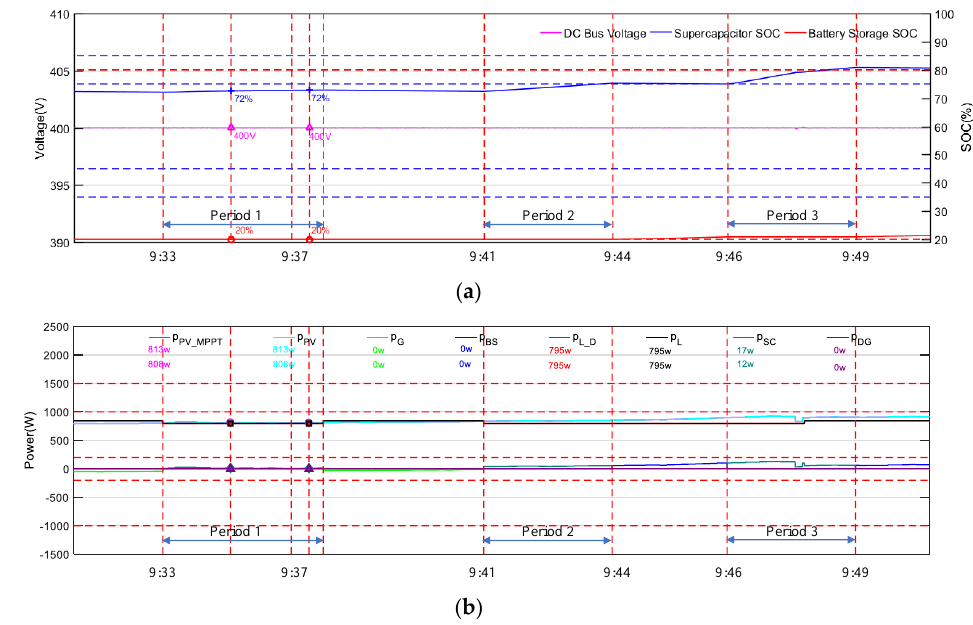
Figure 15. Curves of common DC bus voltage and SOC of storage ( a ) and curves of power ( b ) during SC recharging.